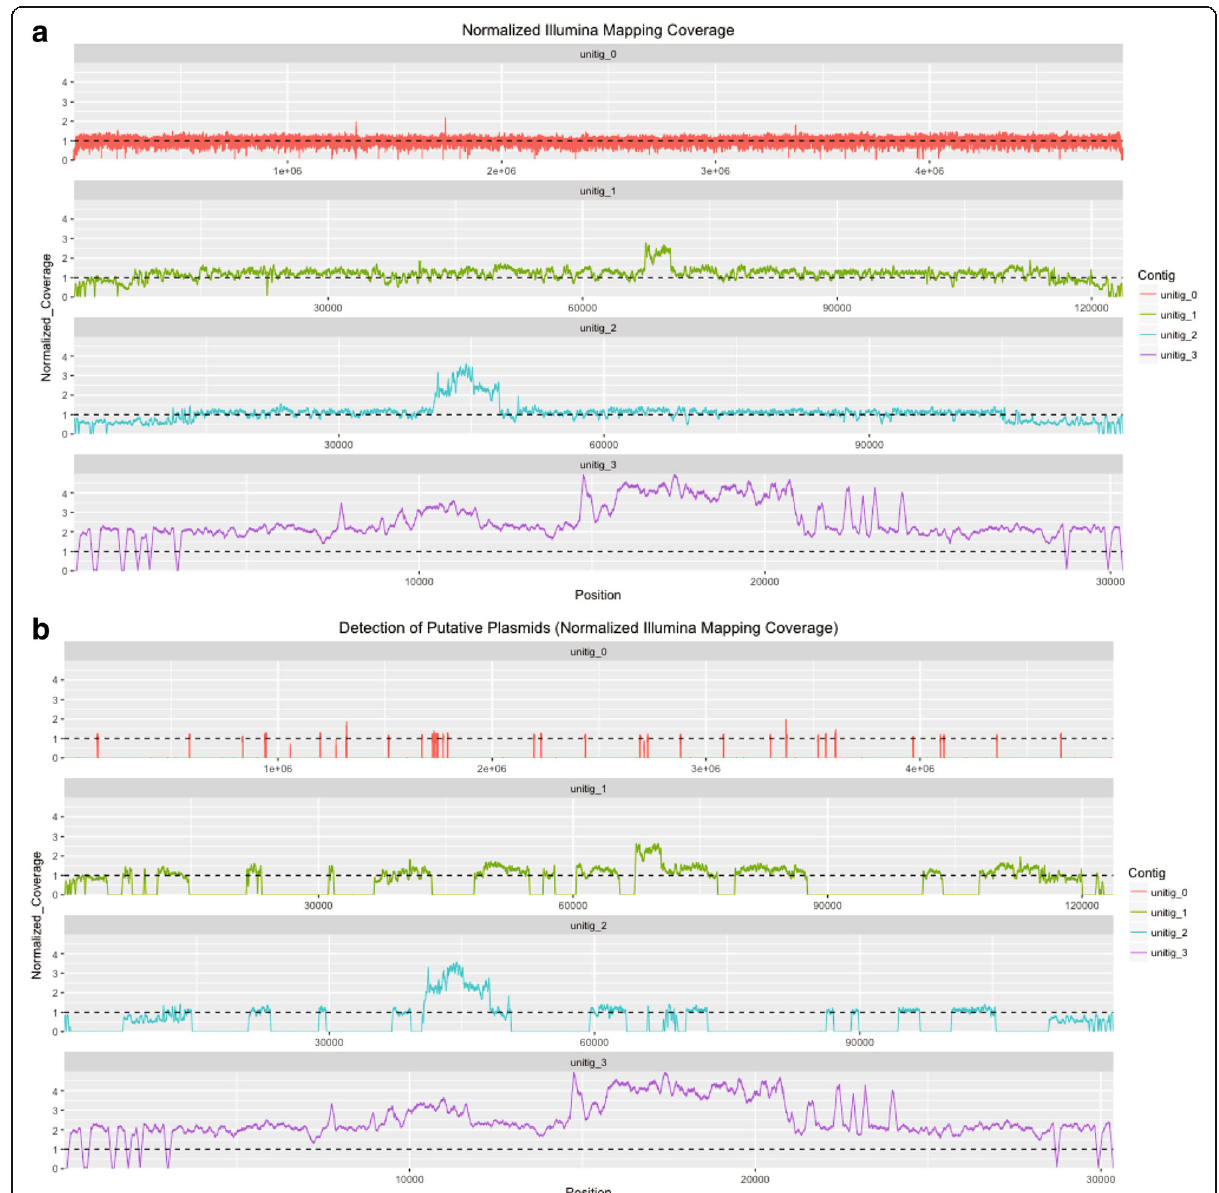
Fig. 3 Illumina single-end reads mapped against PacBio contigs. a Copy number variation along the 4 PacBio large contigs, as determined from Illumina coverage. Copy numbers (ordinates) were normalized to 1 (for haploids). b Copy number variation along the 4 PacBio large contigs, as determined by remapping of putative plasmid reads identified by plasmidSPAdes. Copy numbers (ordinates) were normalized to 1 (for haploids)